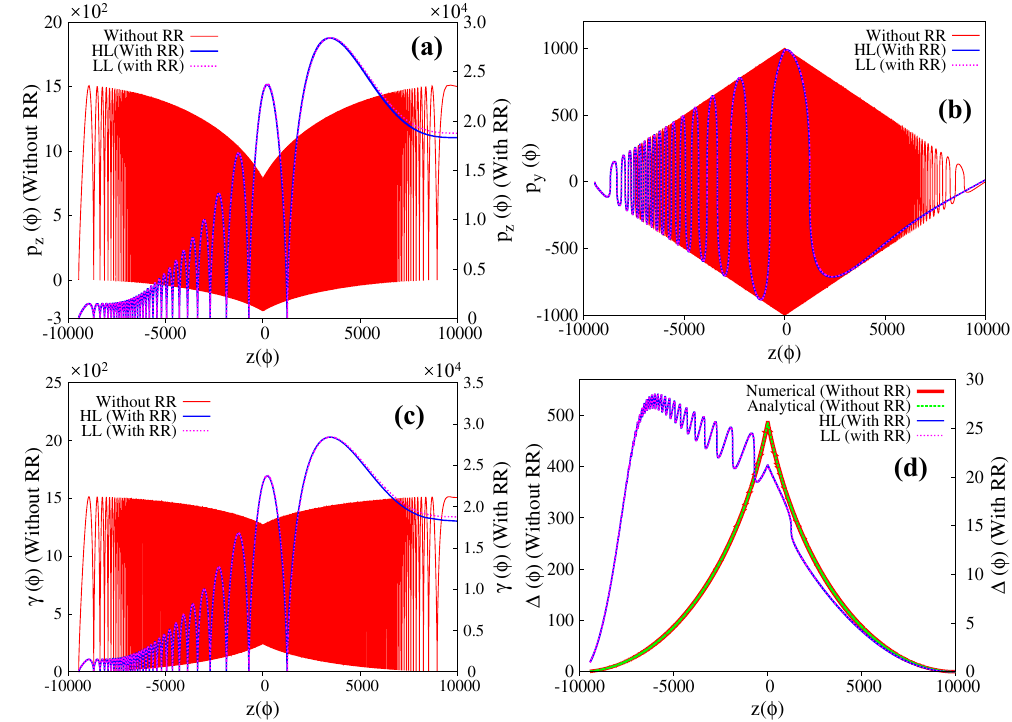
Figure 7. ( a )–( d ) Respectively represent the evolution of longitudinal and transverse momentum, the energy 0 ), intense, focused and the parameter (cid:31) , for a charged particle interacting with a linearly polarized ( δ = electromagnetic wave, in the absence/presence of radiation reaction effects. The intensity at the focal point is 8 . The initial conditions are z 0 9450 , 0 , 1000 ( 1.8 10 10 24 W / cm 2 ) and τ 0 p chosen as a 0 − � = ≈ × = − = ∼ 0 and a ( z 0 ) 1070.9 > a 0 ; see text). The 55 , which violate the inequality given by Eq. (16) ( a P 0 z ref = = = ⊥ red curve in ( a )–( c ) represent the motion of the particle in the absence of radiation reaction effects (values correspond to y-axis on the left), and the corresponding value of the parameter (cid:31) is represented in ( d ) where the red and green curve respectively represent the numerical values and the analytical expression for (cid:31) . The blue and magenta curves in the ( a )–( d ) respectively represent the dynamics in the presence of radiation reaction effects (values correspond to y-axis on the right) as governed by Hartemann-Luhmann and Landau-Lifshitz equation of motion. Note that the apparent discrepancy in the initial conditions seen in ( a ) for without and with radiation reaction is due to the use of different axes i.e. left y-axis is for without radiation reaction and right y-axis is for with radiation reaction